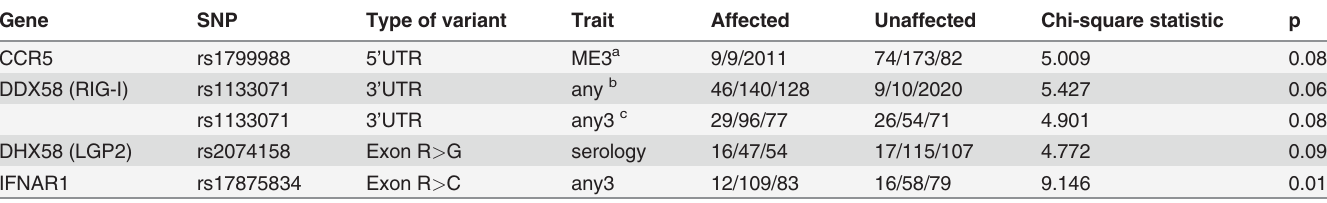
Table 3. Genetic association analysis results from additive model.